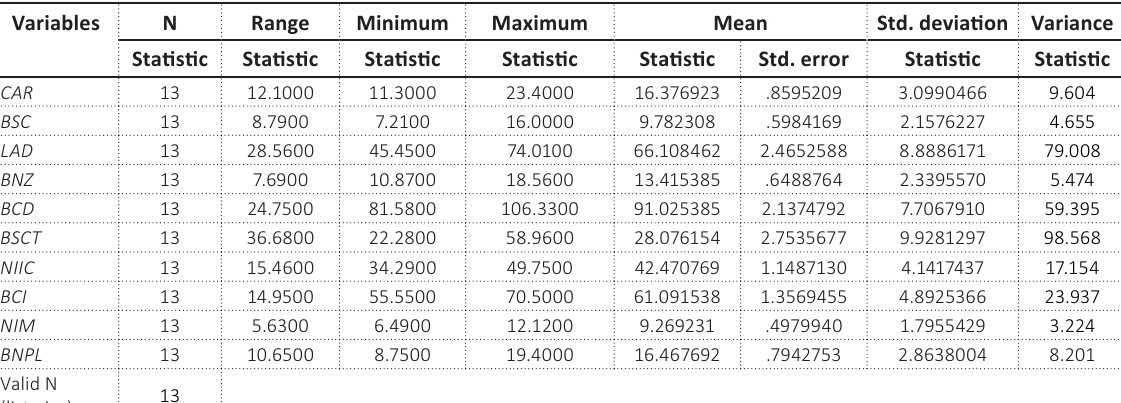
Table 1. Descriptive statistics analysis (pre-recapitalization)